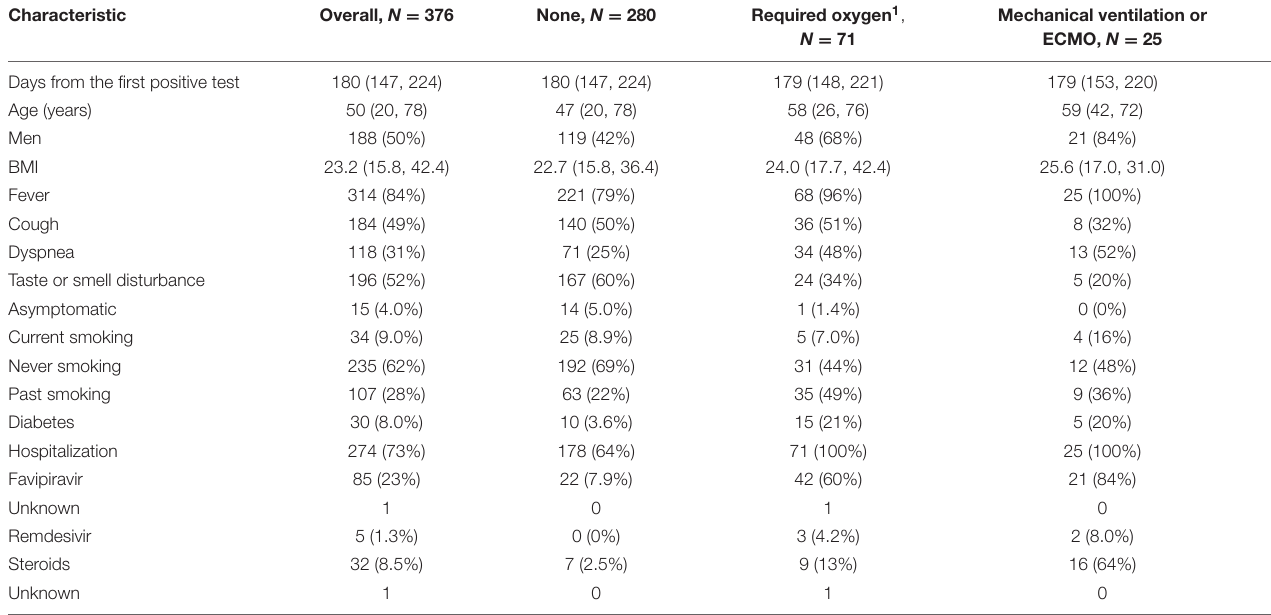
TABLE 1 | Characteristics of participants overall and with stratification by requirement of oxygen support ( N = 376).